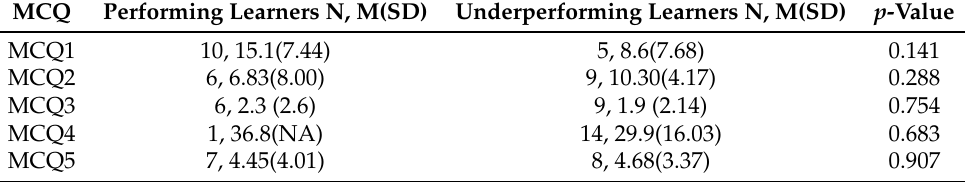
Table 2. Mean and Standard Deviation of performing and underperforming learners for %Gaze Duration on